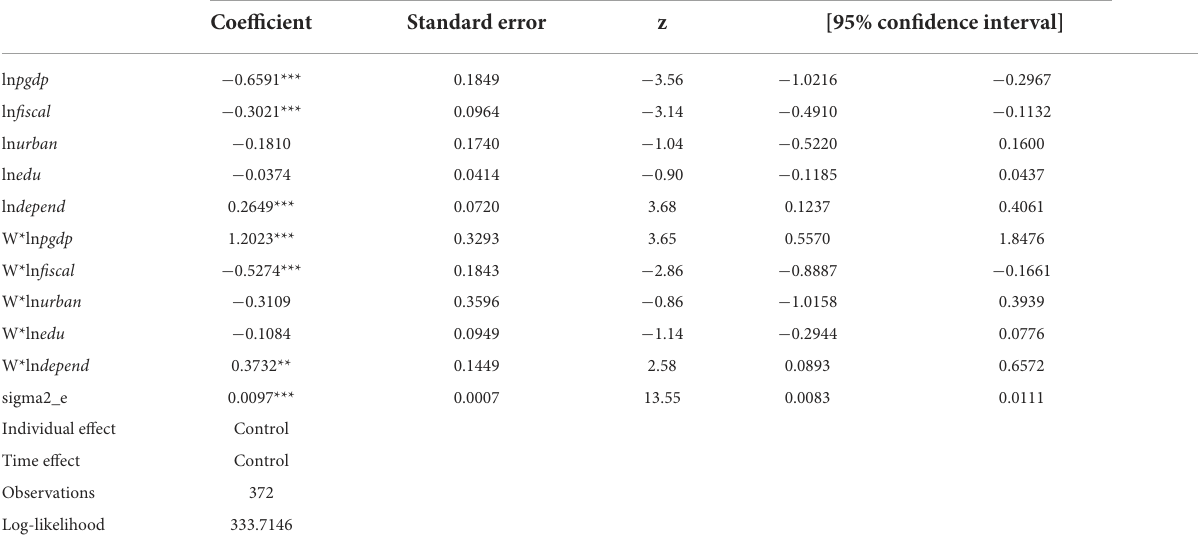
TABLE 7 Regression results of the spatial Durbin